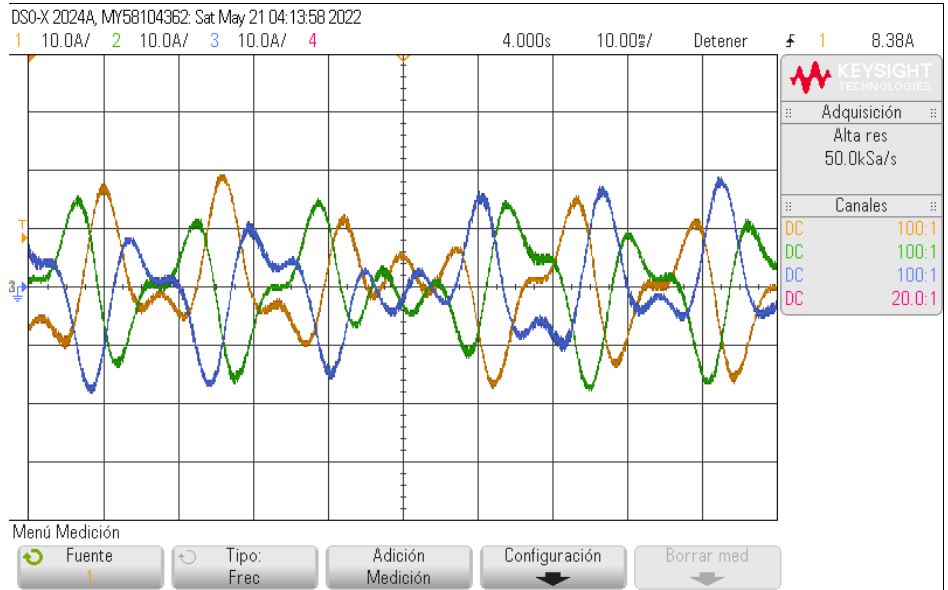
Figure 14. 100 ms of oscilloscope currents wave-forms with harmonic insertion for electrical parame- ters estimation during 180 s testing.